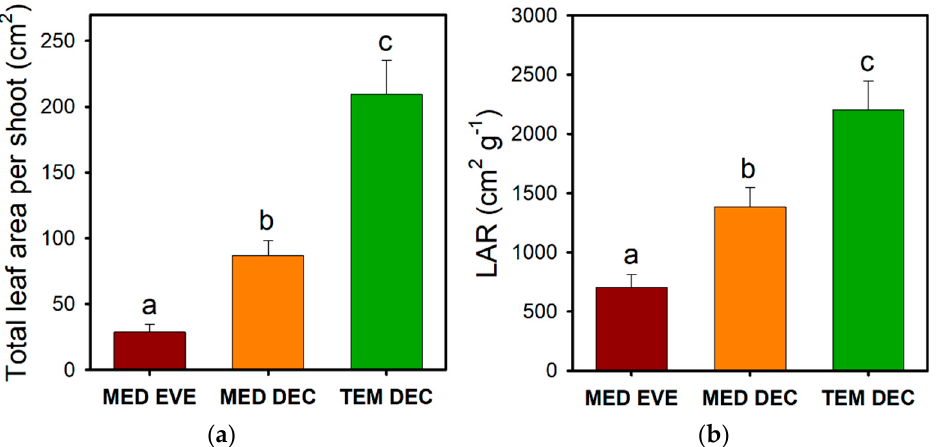
Figure 3. ( a ) Total leaf area per shoot (cm 2 ) and ( b ) leaf area ratio (LAR, cm 2 g − 1 ) of Mediterranean evergreen (MED EVE), Mediterranean deciduous (MED DEC), and Temperate deciduous (TEM DEC) oaks. Data are mean ± s.e. of five species. Different letters indicate statistically significant differences (Tukey test, p < 0.05) (Supplementary Materials).